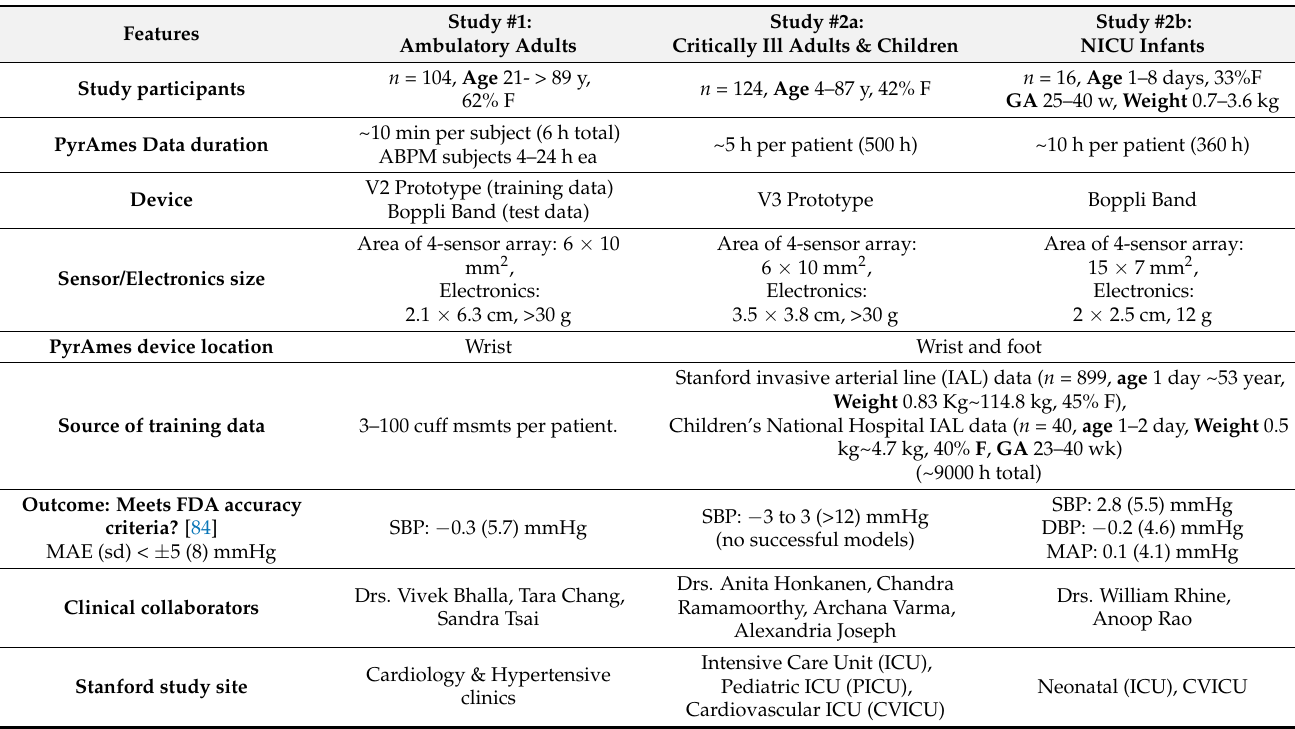
Table 2. Feasibility Studies.